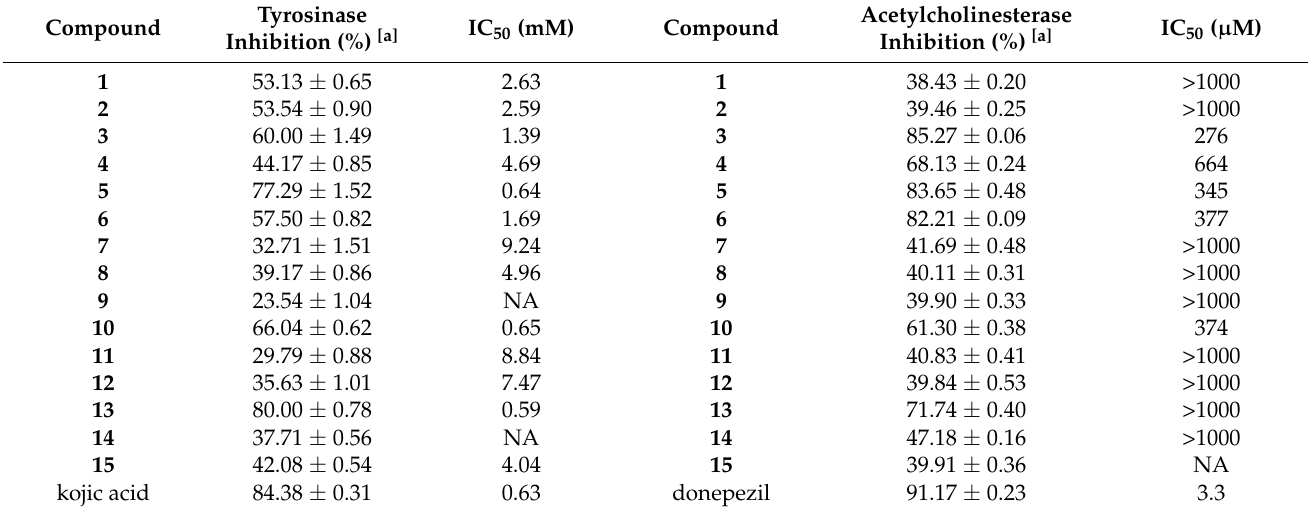
Table 2. Tyrosinase and acetylcholinesterase inhibitory activities of 1 – 15